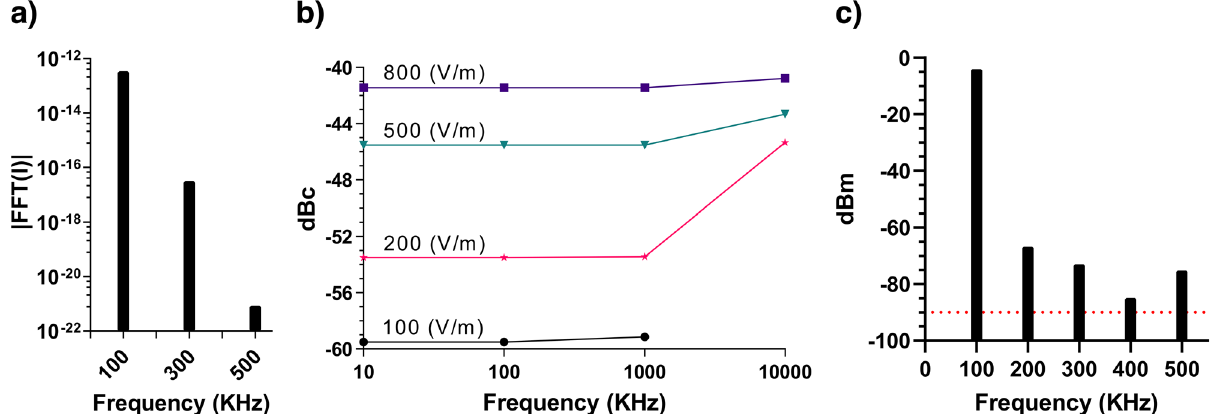
Figure 5. Simulated power spectrum and harmonics of virus and virus-free salt samples. ( a ) Simulated power spectrum of the voltage recorded from a virus suspension solution. ( b ) The ratio of the third harmonic to the main harmonic amplitudes versus frequency for different stimulation amplitudes. ( c ) Harmonics of the 280 mM NaCl solution. Drawings were made using Inkscape version 1.1 and GIMP version 2.10.28 (http:// www. gimp. org, http:// www. inksc ape.